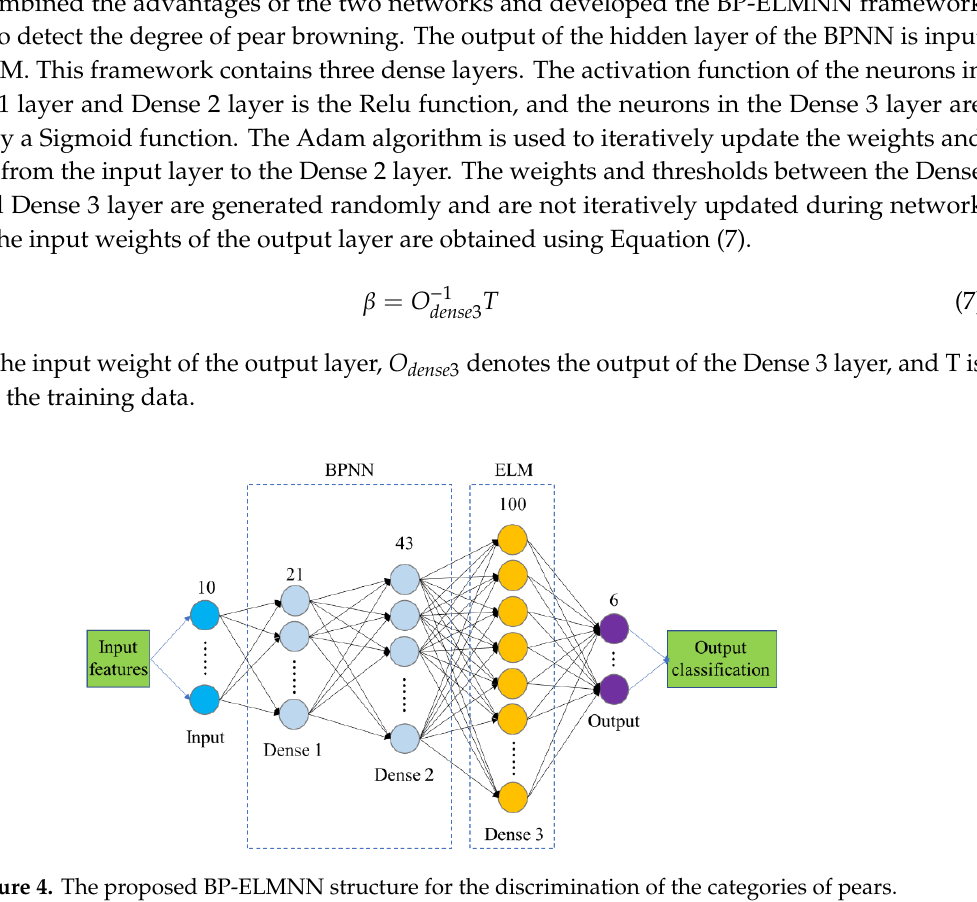
Figure 4. The proposed BP-ELMNN structure for the discrimination of the categories of pears.